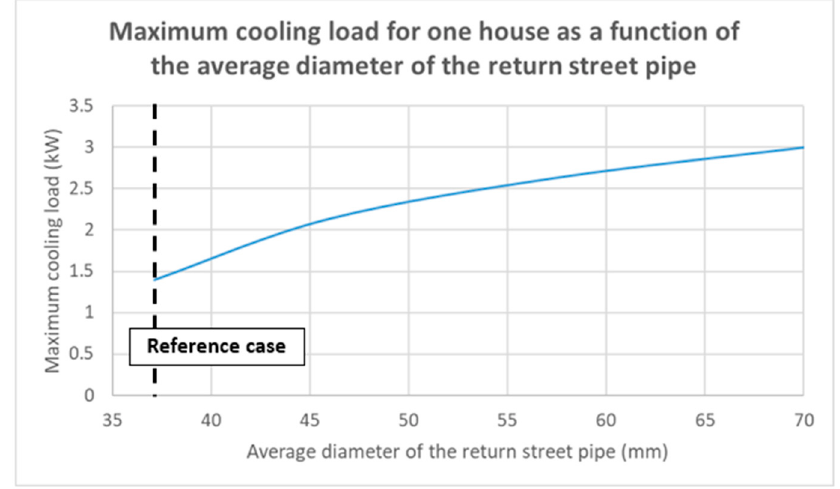
Figure 16. Cooling load per house as a function of the street pipes’ diameters in the cluster.